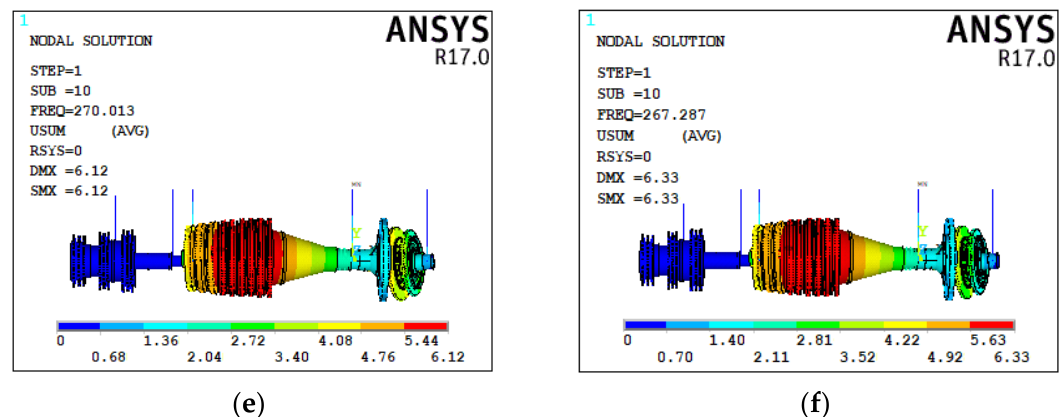
Figure 15. The 5th order modals for contrast in different parallel non-concentricity: ( a ) δ = 0.5 mm; ( b ) δ = 1.0 mm; ( c ) δ = 1.5 mm; ( d ) δ = 2.0 mm; ( e ) δ = 2.5 mm; ( f ) δ = 3.0 mm.